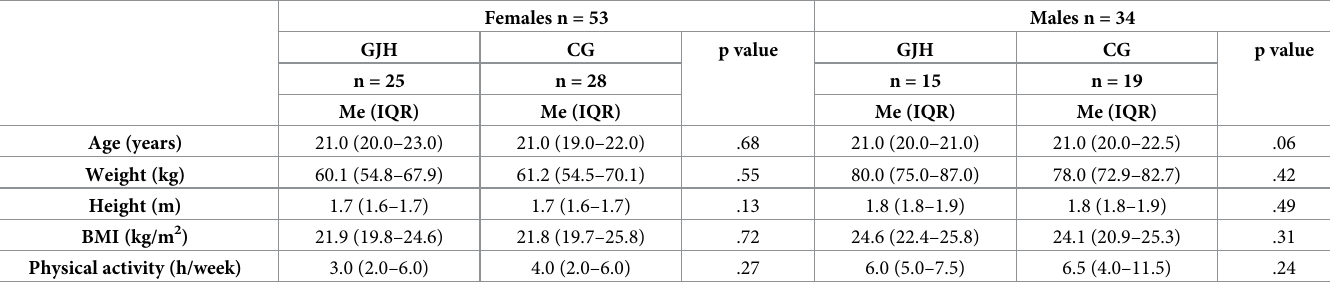
Table 1. Characteristics of women and men with GJH and from the